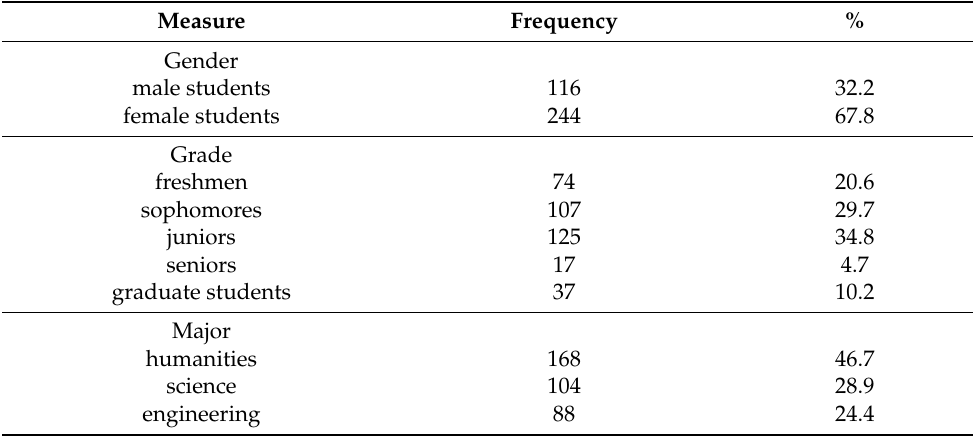
Table 1. Summary of the demographic statistics (N =